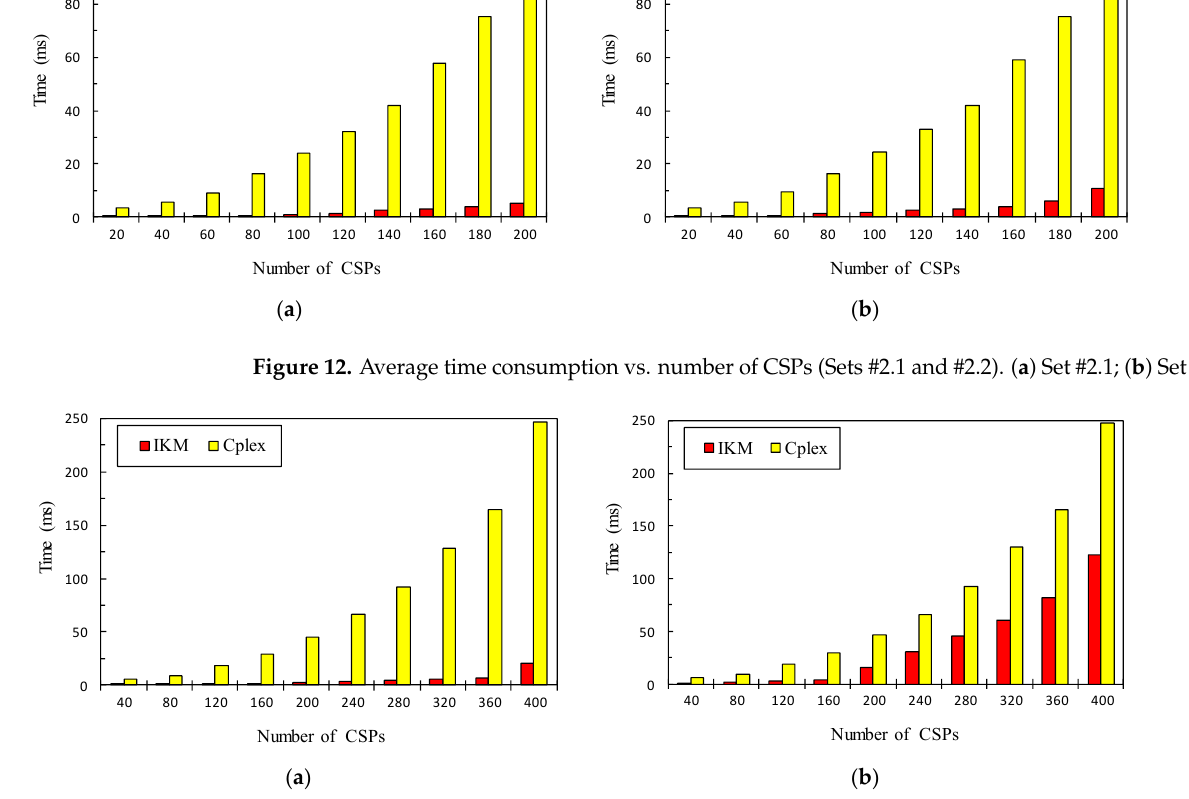
Figure 13. Average time consumption vs. number of CSPs (sets #2.3 and #2.4). ( a ) Set #2.3; ( b ) set #2.4.